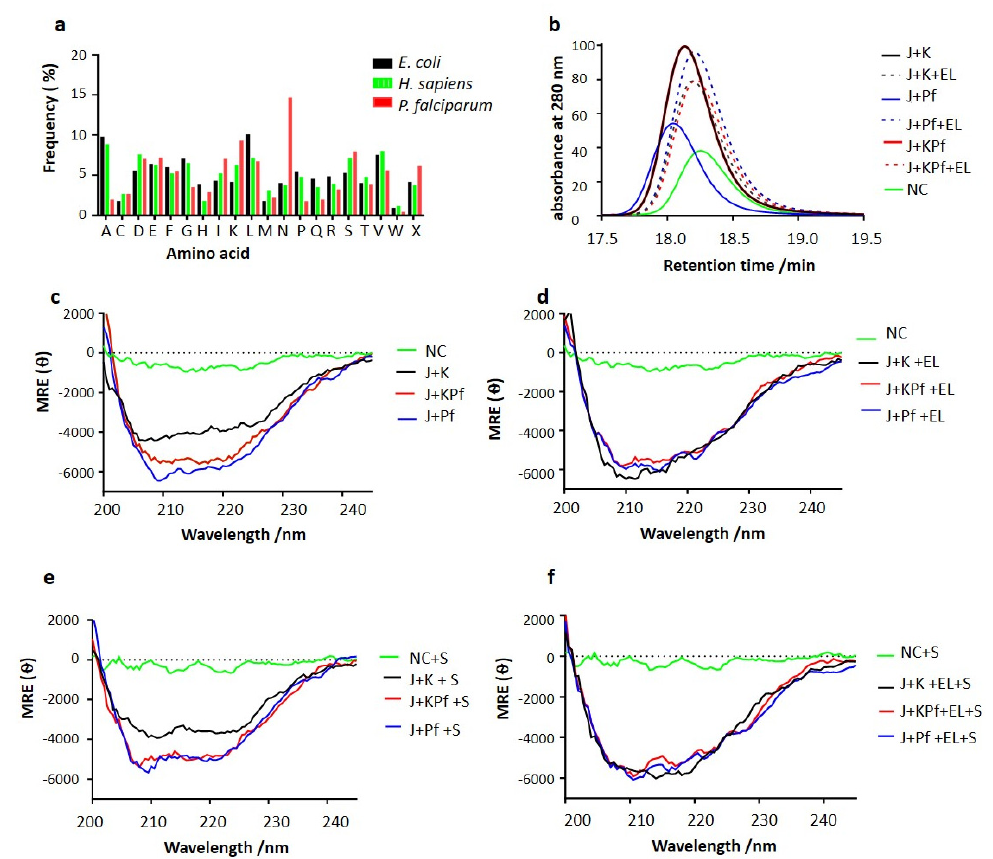
Figure 3. PfAdoMetDC co-produced with PfHsp70-1 and KPf is structurally unique secondary structure from that co-produced with DnaK. Amino acid compositions of AdoMetDC of H. sapiens, E. coli and P. falciparum origins ( a ). PfAdoMetDC was co-produced either alone (NC) or in the presence of supplementary chaperone sets: DnaK + DnaJ (J + K); DnaK + DnaJ + GroEL (J + K + EL); PfHsp70-1 + DnaJ (J + Pf); PfHsp70 + DnaJ + GroEL (J + Pf + EL); KPf + DnaJ (J + KPf); and KPf + DnaJ + GroEL (J